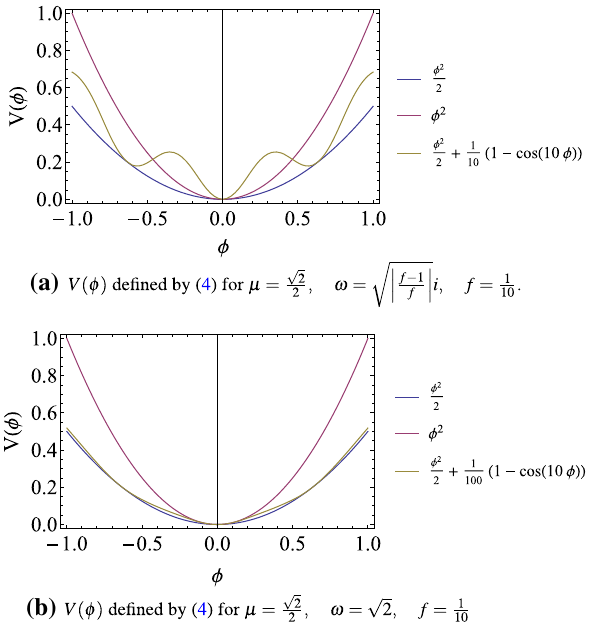
Fig. 1 Generalized harmonic potentials. Comparison with φ -squared